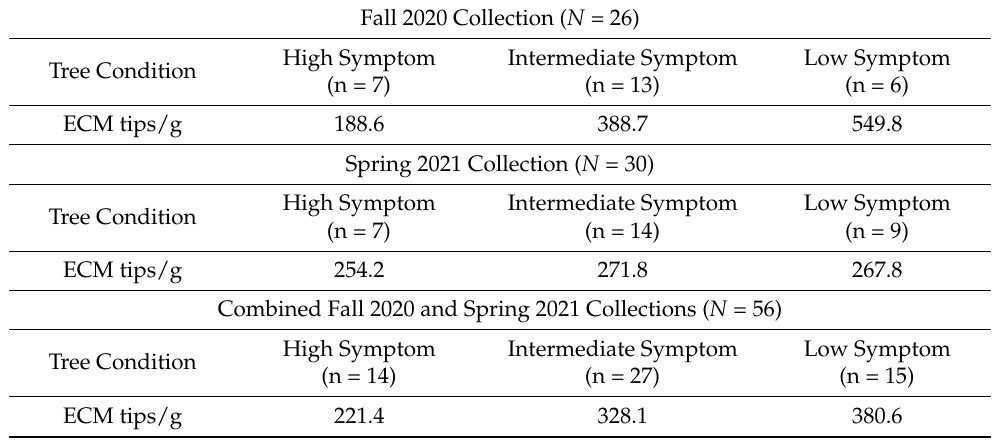
Figure 1. Mycorrhizal colonization expressed as root tip abundances per gram of dried course root material was plotted to indicate significant differences between treatments. ( a ) Colonization is plotted according to BLD symptom severity in both the fall 2020 and spring 2021 collections. The fall 2020 collection showed significantly different abundances between high- and low-symptom sever- ity trees ( p = 0.03; *) and moderate differences between high- and intermediate-symptom severity trees ( p = 0.07; (cid:78) ). ( b ) Colonization is plotted according to collection season for both provenances (Maine and Michigan) to visualize differences in colonization according to tree provenance. Michigan trees had significantly greater colonization regardless of season, as indicated by root tip abundance ( p = 0.003; **). While provenance did not impact colonization in the fall collection alone, coloniza- tions from the spring collection were significantly different between Maine and Michigan trees ( p < 0.001, ***). Table 2. Mean abundance of ECM root tips from fall 2020, spring 2021, and the combined collections at varying tree conditions of BLD. The total numbers of colonized root tips were standardized per 1 g of dried root biomass. Tree condition was determined by two independent observers. Root tip abundance varied significantly between tree conditions in the fall 2020